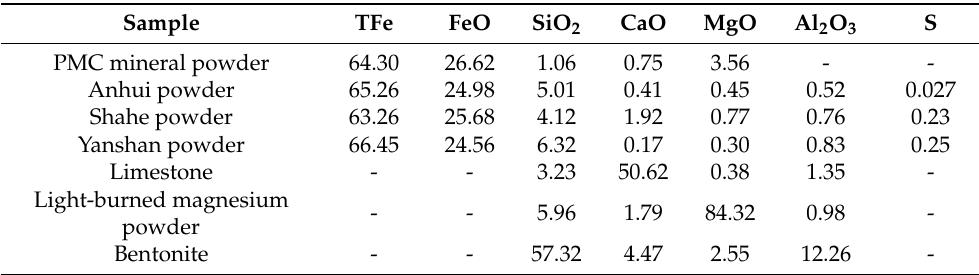
Table 1. Main chemical compositions of mineral powders (%).